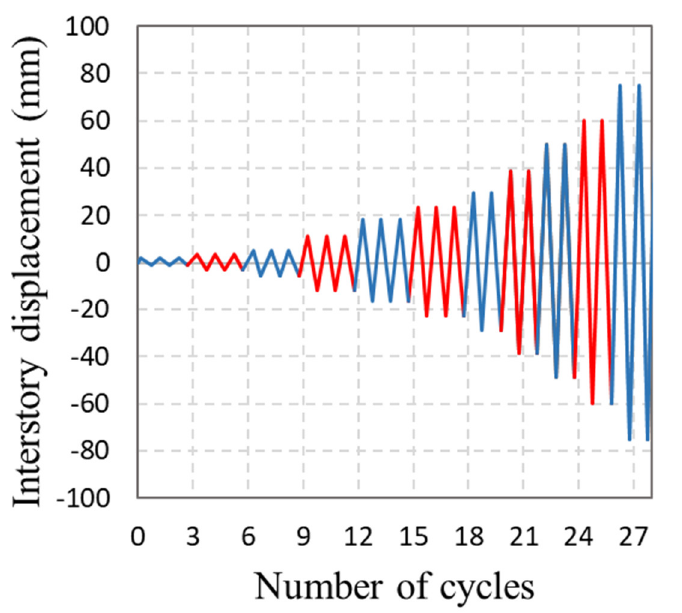
Figure 8. Cyclic lateral loading used by Vian et al. [32].